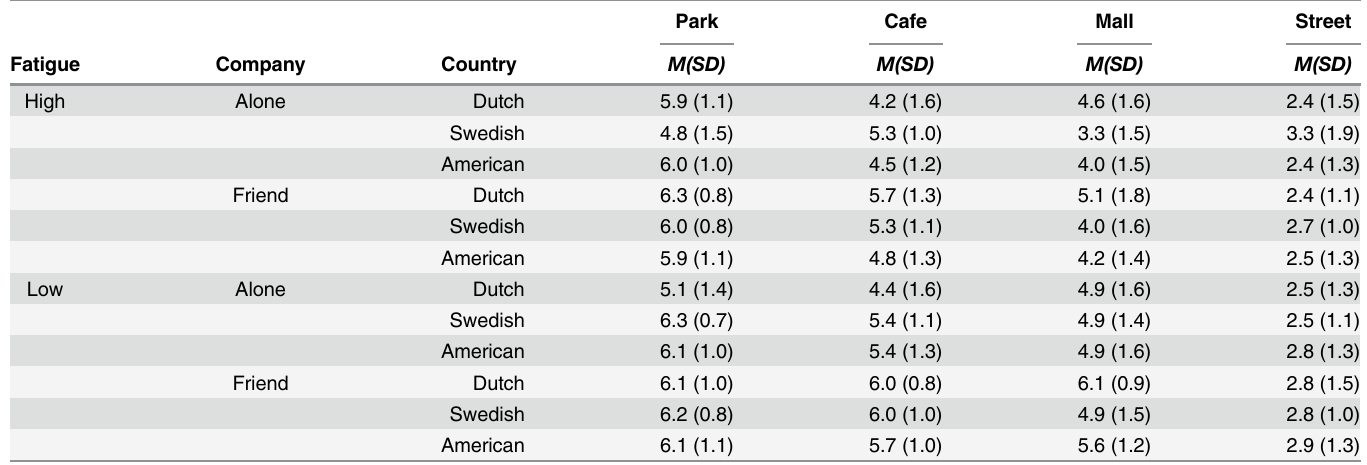
Table 4. Preference scores for the four settings (means and standard deviations) broken out for conditions of attentional fatigue, company and country.